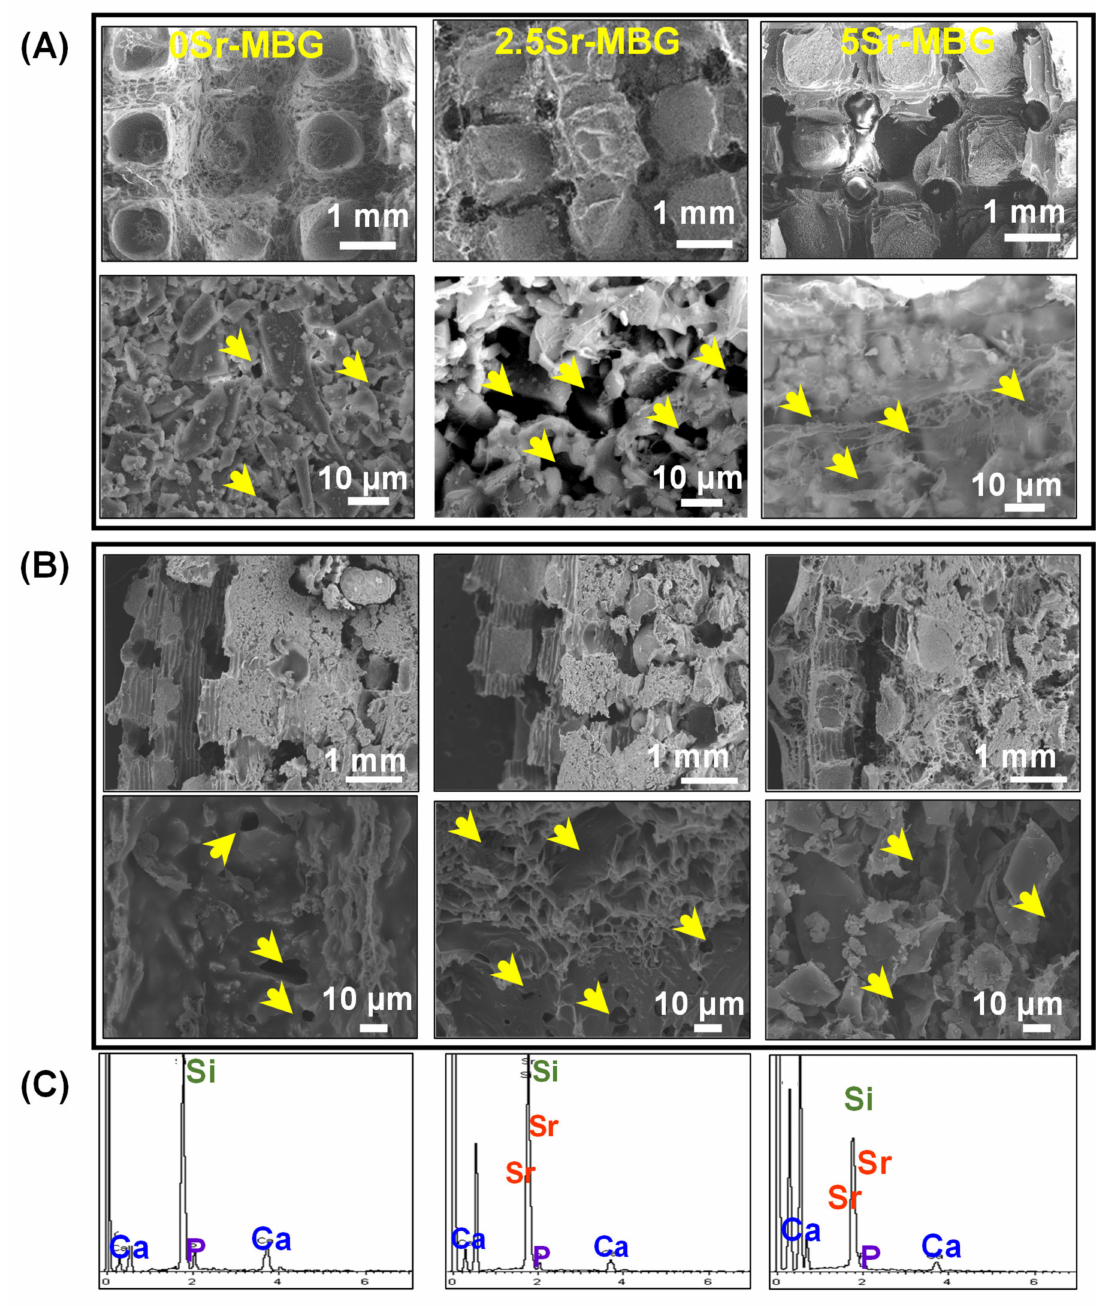
Figure 7. SEM images of ( A ) surface and ( B ) fracture of 0Sr-MBG, 2.5Sr-MBG and 5Sr-MBG sca ff olds. Arrows indicate the macroporosity lower than 10 µ m. ( C ) The corresponding EDS of MBG sca ff olds spectra are